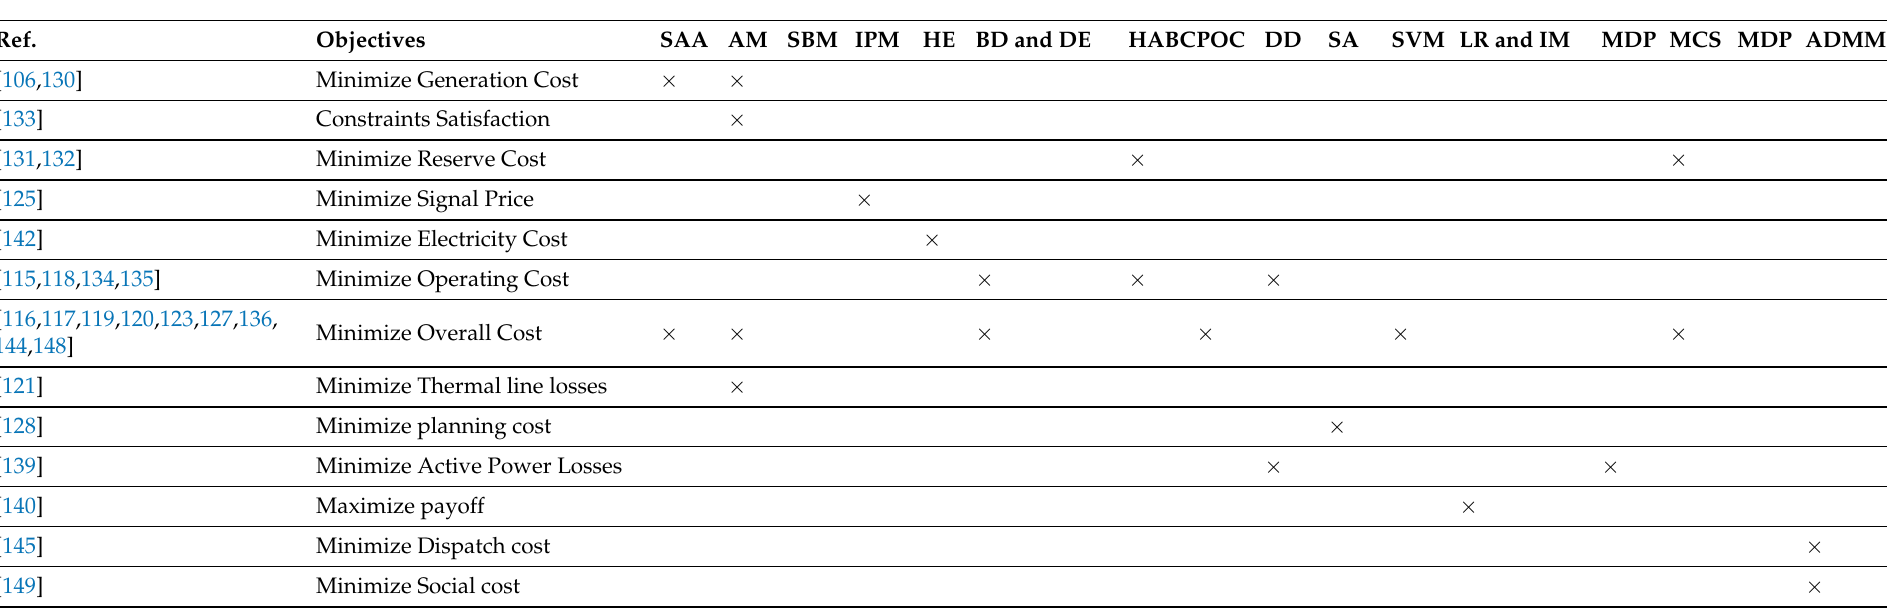
Table 6. Objectives of chance constrained optimization and the solution algorithms.